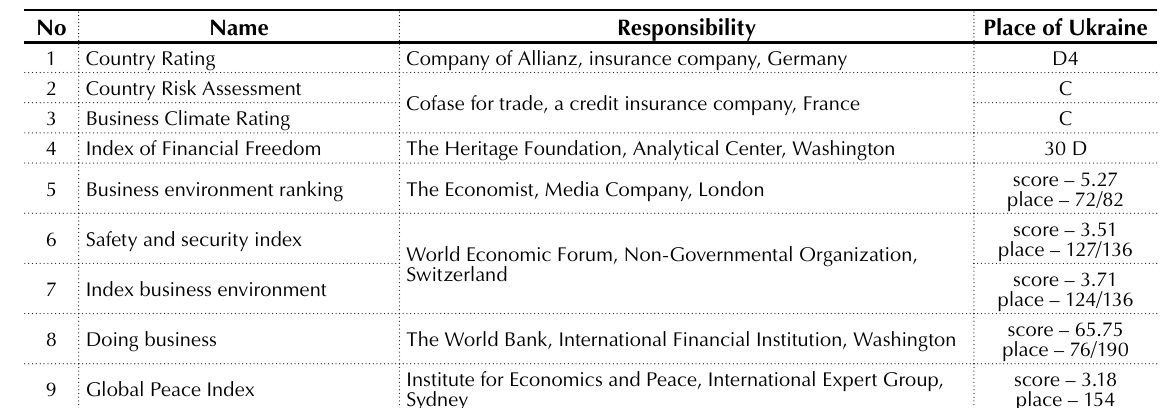
Table 5. Ukraine in the system of international ratings in